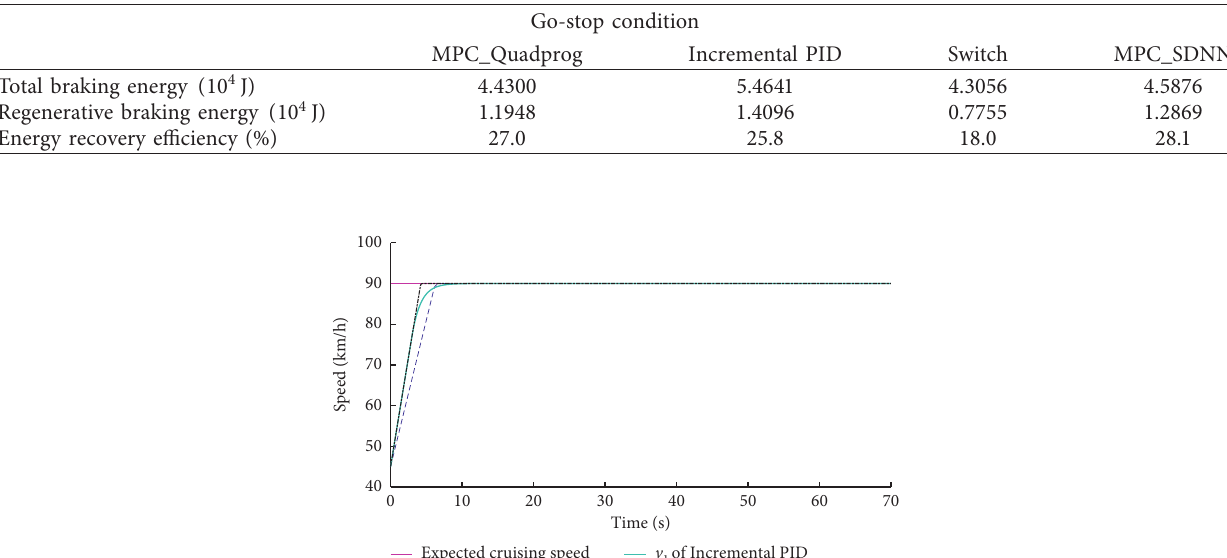
Figure 21: Regenerative braking energy of four controllers. Table 14: Performance of energy recovery in braking in the go-stop condition.